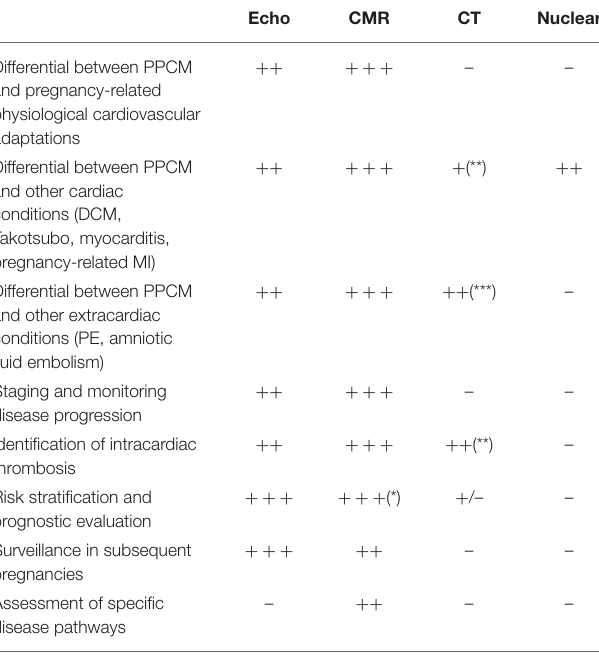
TABLE 2 | Value of cardiac imaging modalities in peripartum cardiomyopathy. Echo CMR